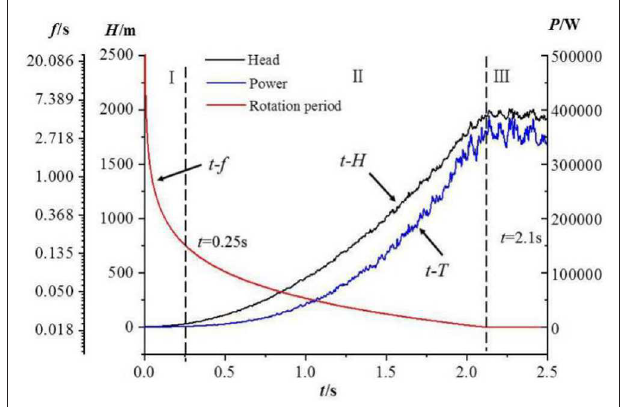
FIGURE 4 | Pump characteristic change during the start-up process of the closed-valve